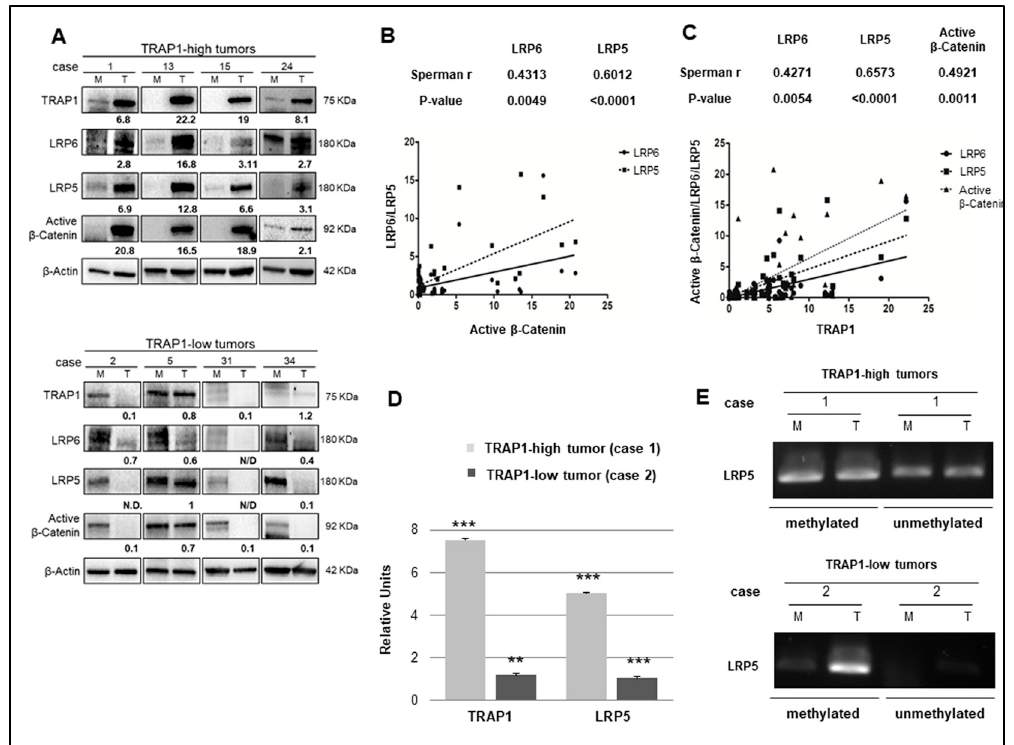
Figure 6. TRAP1 is co-expressed with active β -Catenin and LRP5/6 in human CRCs. ( A ) Total cell lysates from eight representative human CRCs (T) and the respective peritumoral non-infiltrated mucosas (M) were separated by SDS-PAGE and immunoblotted with the indicated antibodies. ( B , C ) Dot plots representing the correlation between active β -Catenin and LRP5/LRP6 ( B ) and between TRAP1 and active β -Catenin/LRP5/LRP6 ( C ) in our series of 41 colorectal carcinomas. ( D ) Real Time PCR analysis of LRP5 mRNA expression in two representative cases of human CRCs, represented as time increase compared to the respective non-infiltrated normal mucosa. Statistical significance respect to the respective control: ** p < 0.01; *** p < 0.001. ( E ) Methylation specific PCR representing the level of LRP5 promoter methylation in two representative cases of human CRCs.